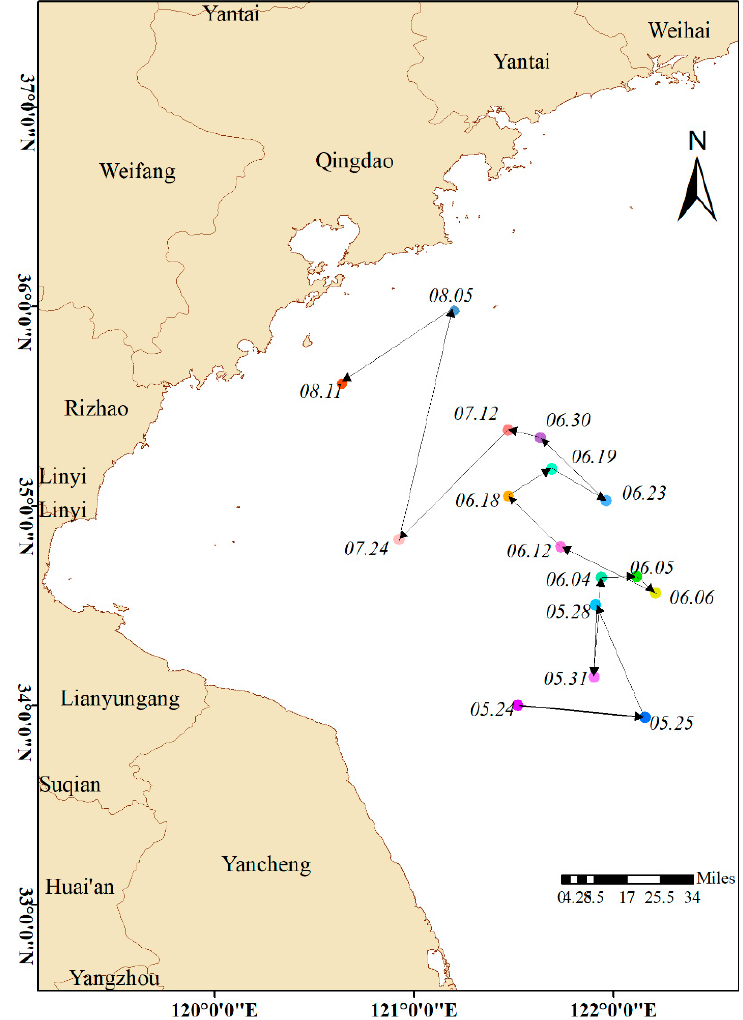
Figure 14. Thematic map of Ulva prolifera drift trajectory.